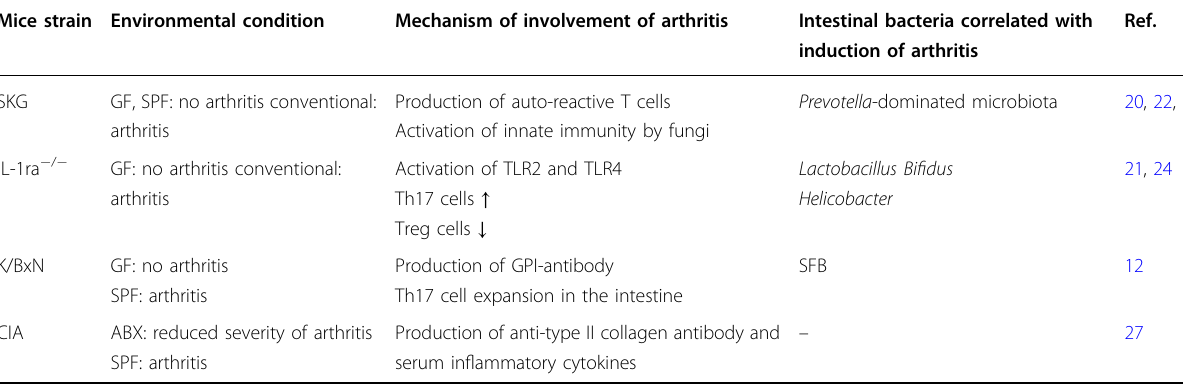
Table 1 Murine models of arthritis known to be correlated with the gut microbiota Mice strain Environmental